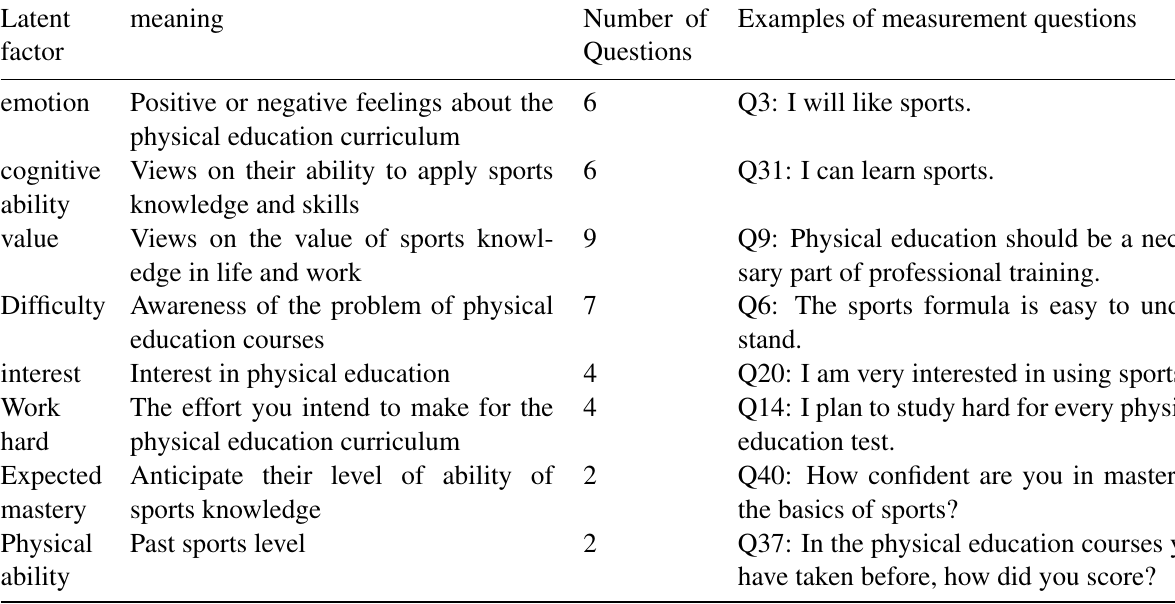
Table 1 Eight potential